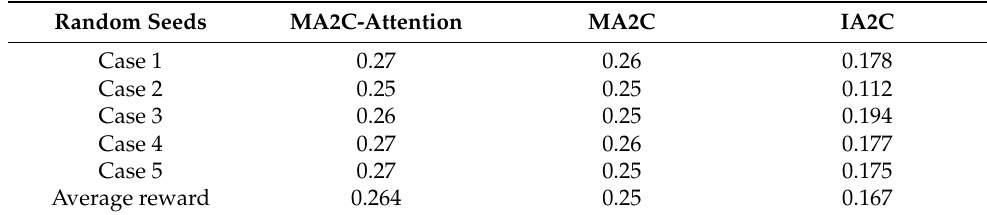
Figure 5. The average reward value under different algorithms. Table 1. Average reward value under random test.